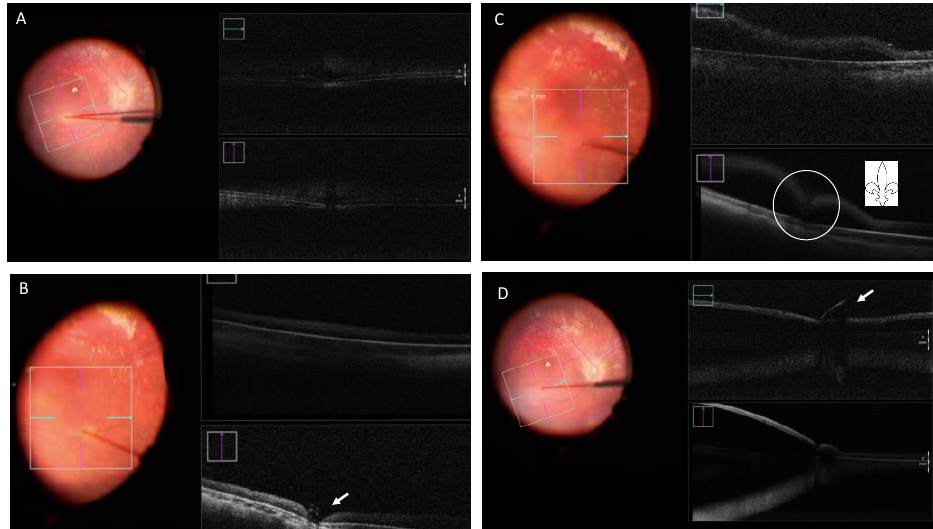
Figure 7. Retinography and intraoperative OCT (iOCT) taken during surgery for Luxturna gene therapy. ( A ) Blanching of the retina and indentation in the iOCT. ( B ) Indentation in the iOCT just before pressing the plunger for the subretinal injection (arrow). ( C ) “Fleur-de-lis” sign at the beginning of the subretinal injection (circle). ( D ) Subretinal bubble, localized retinal detachment and blunt cannula at the edge of the retinotomy (arrow).